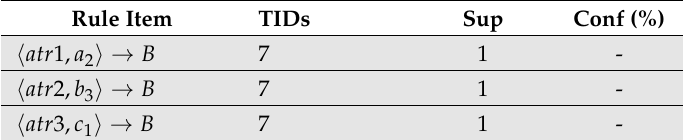
Table 7. Transaction IDs after ECARG2 generated the third